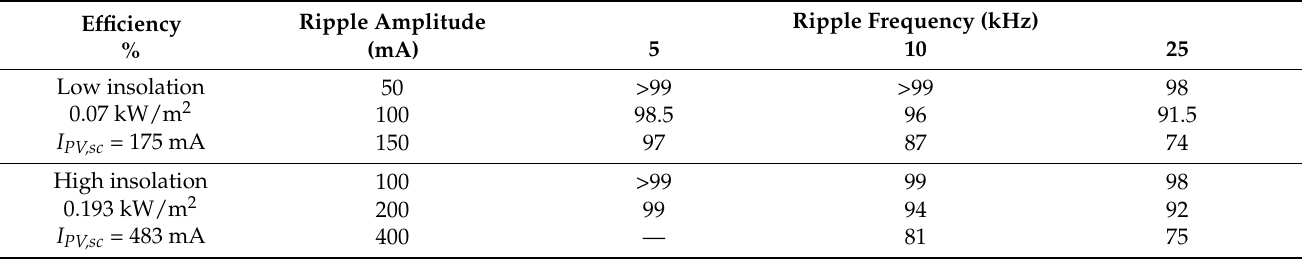
Table 3. PV panel efficiency as a function of ripple (frequency and peak-peak amplitude)